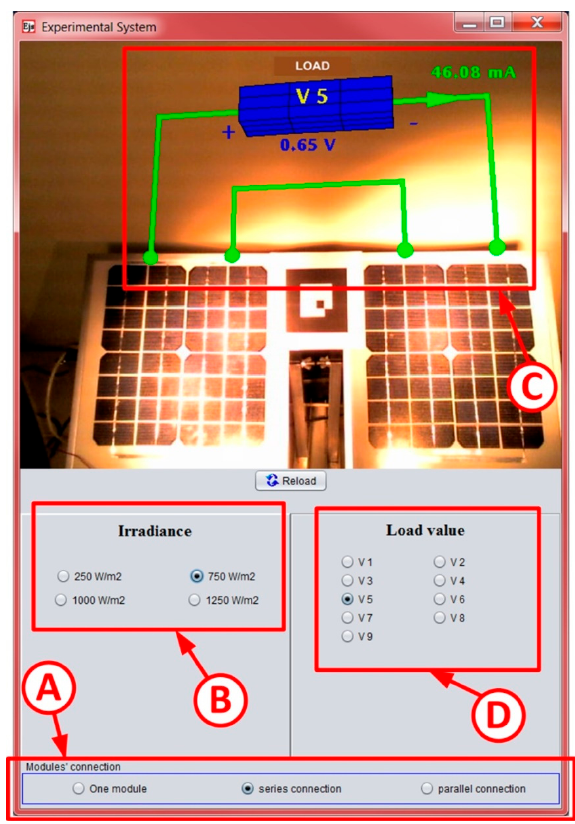
Figure 9. HMI designed in EJS to test the behavior of remote photovoltaic panels.